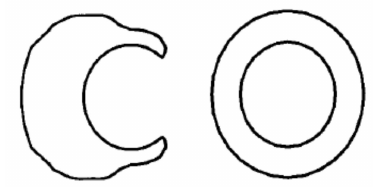
Figure 14. FEM-optimized and circular shape of metal insert